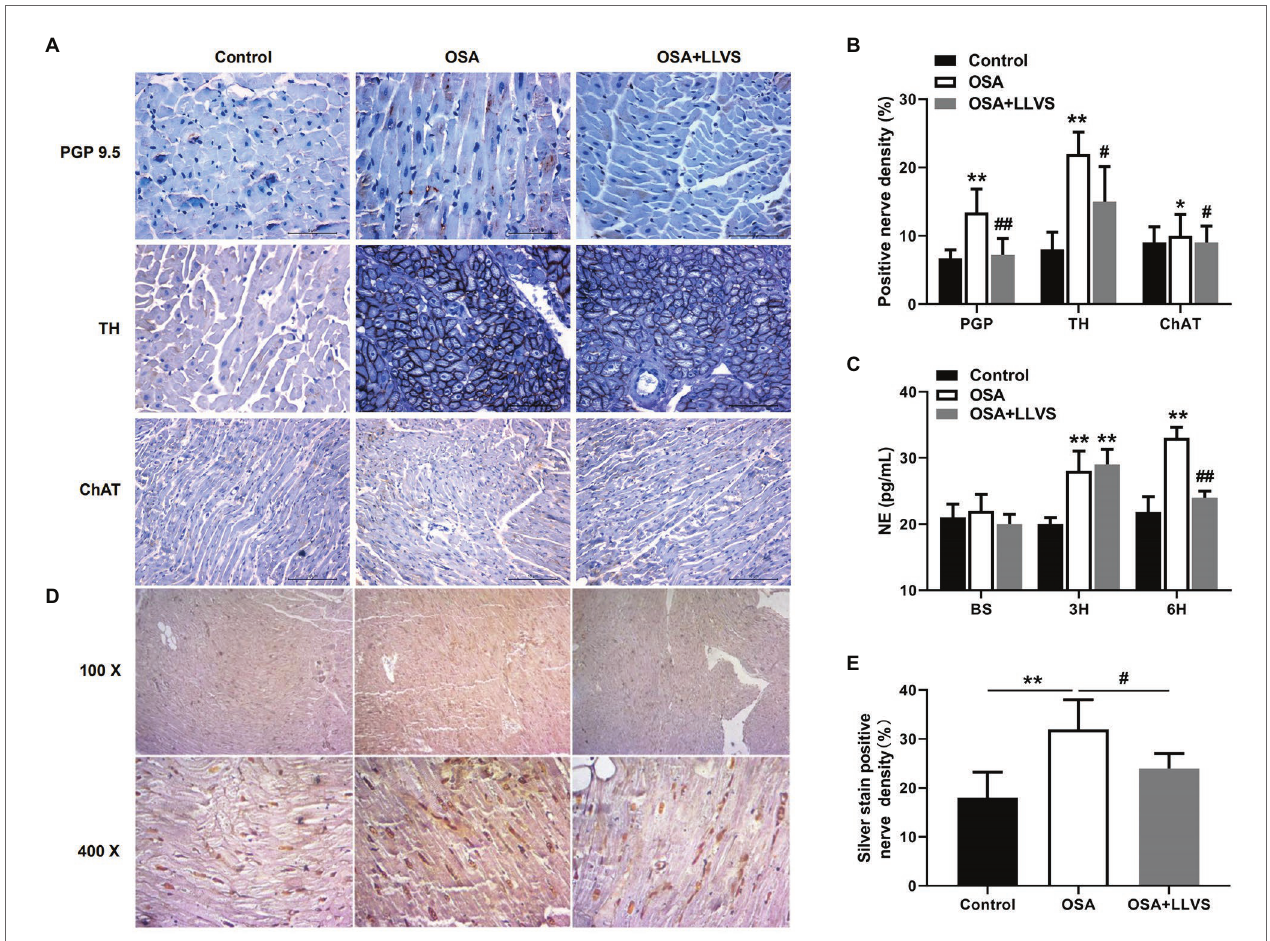
FIGURE 2 | (A) Representative immunohistochemical staining of PGP 9.5, TH, and ChAT on the LA among the three groups. (B) Quantitative analysis of PGP 9.5, TH, and ChAT-positive nerve density in the LA of each group. (C) The concentration of NE among the three groups at baseline, the 3rd hour, and the 6th hour. (D) Representative silver staining in the LA among the three groups. (E) Quantitative analysis of silver staining-positive nerve density in the LA of each group. * p < 0.05, ** p < 0.01 vs. the control group; # p < 0.05, ## p < 0.01 vs. the OSA+LLVS group; PGP 9.5, protein gene product; TH, tyrosine hydroxylase; ChAT, choline acetyltransferase; NE, norepinephrine; H,